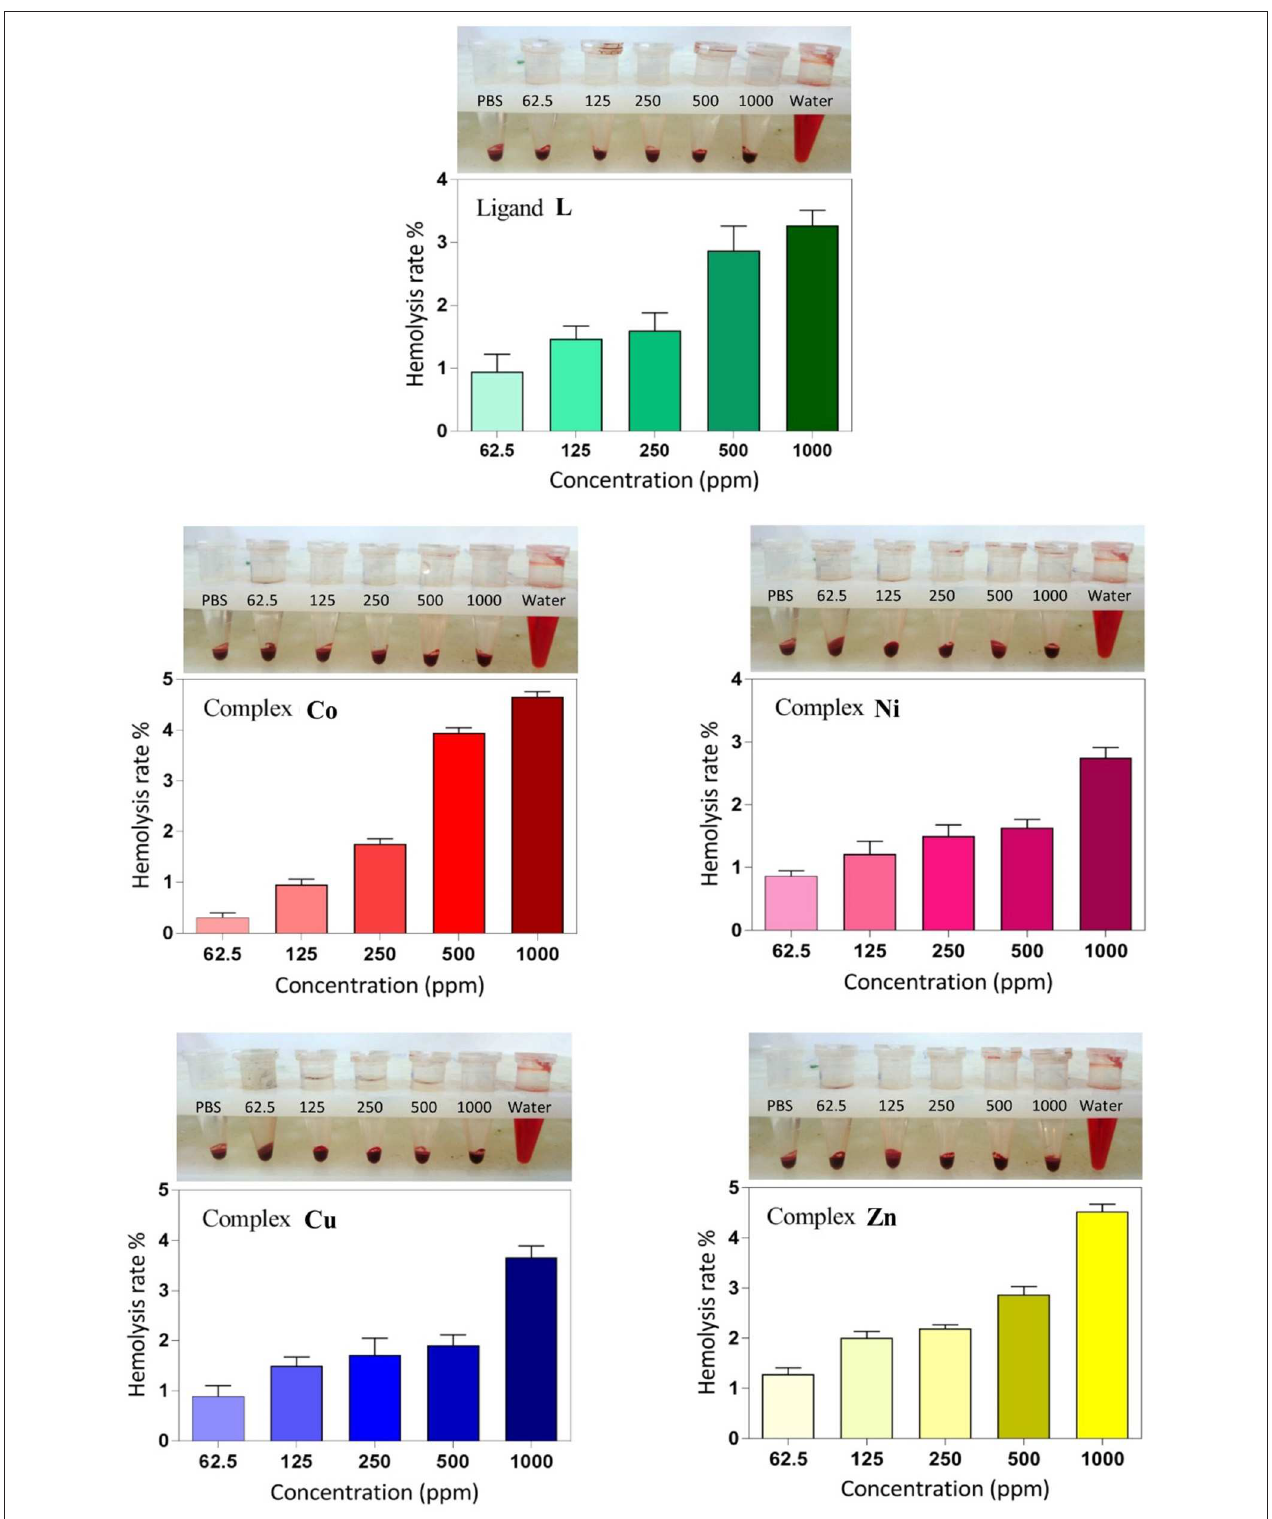
FIGURE 8 | Hemolysis rate of human red blood cells (HRBCs) in the presence of the synthesized samples and the visual observation of hemoglobin in the supernatant at different concentrations (ppm).